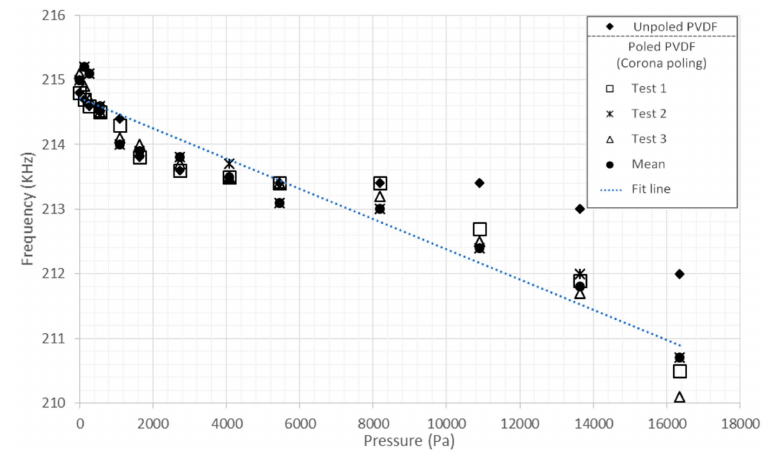
Figure 8. Response of the prosthesis of PVDF as a pressure sensor from 0 to 16,350 Pa.